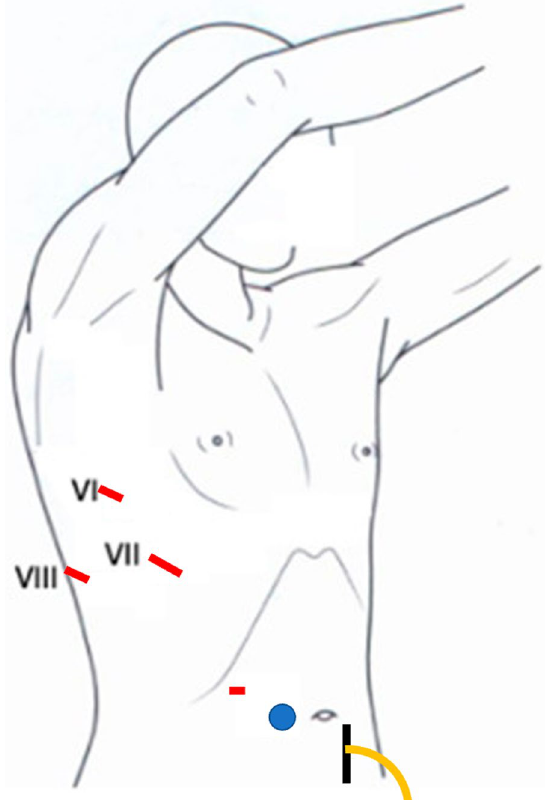
Fig. 2 Intraoperative position of the patients and the thoracoscopic and laparoscopic ports. VATS in the left-sided half-lateral decubitus position; three 2-cm thoracic ports were created in the seventh, sixth, and eighth intercostal spaces on the anterior, middle, and posterior axillary lines, respectively. A thoracoscope was inserted in the middle axillary line and the other two ports were used to expand the operative fields. One skin incision was made to the right side of the navel, and a laparoscope was inserted into the port (blue round) because a 5-cm longitudinal incision had been made 17 cm cranially from the pubic bone and two lateral fingers to the left of the navel for the placement of the PD catheter (black vertical line). In cases without bubbles, we added an additional laparoscopic port under the right hypochondrium (red horizontal line) to carefully observe the